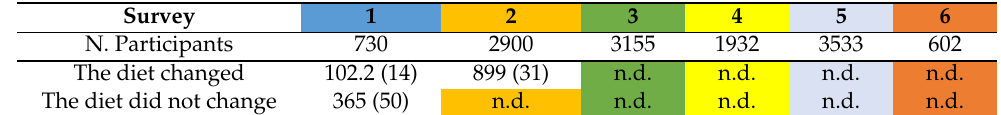
Table 7. Changes in diet, absolute value (N.) and (%) on the total.